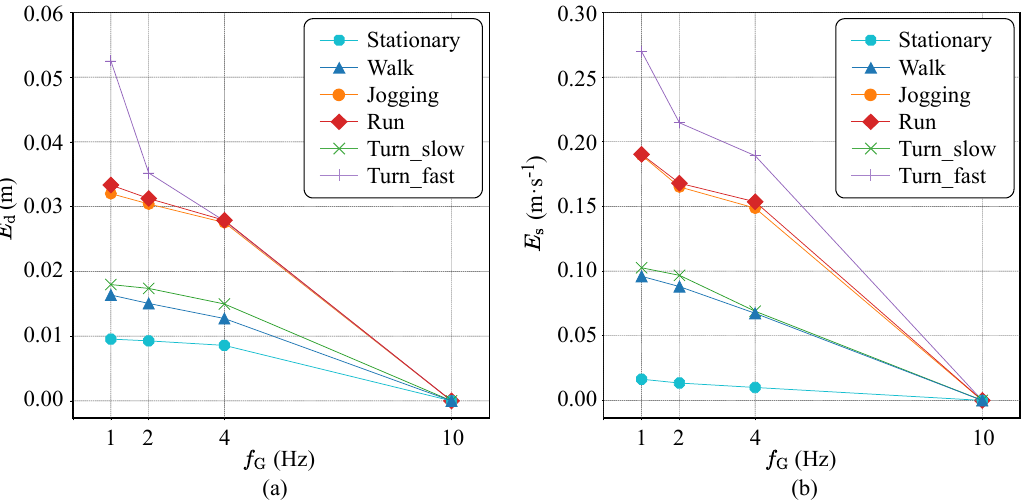
Figure 9. Measurement errors for different football activities in terms of ( a ) distance and ( b ) speed ( f I = 100 Hz).